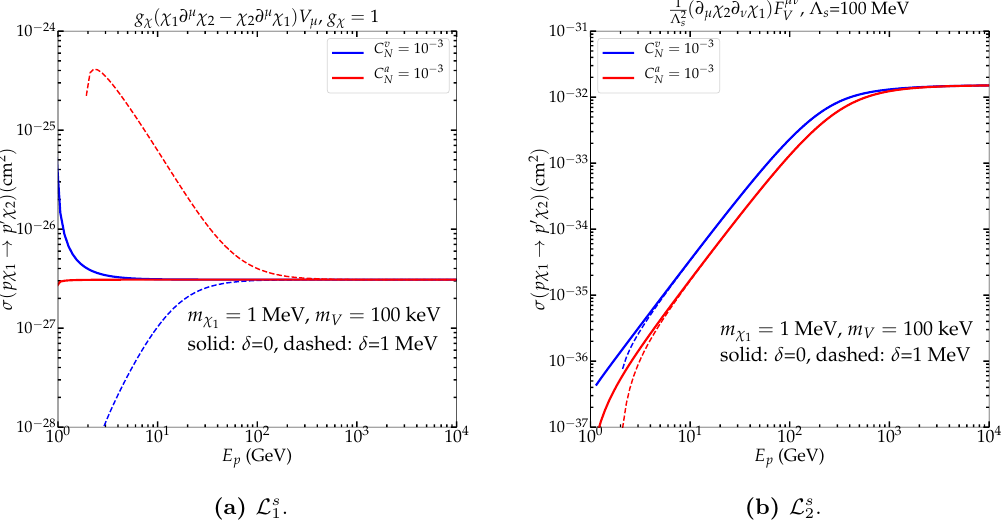
Figure 4. The integrated cross section between scalar DM and an incoming proton as a function of its energy E . A nonzero δ contributes to an enhancement for Lagrangian L s p vector interaction. For L s , the resulting difference between the SM vector and axial vector interac- 2 tion is